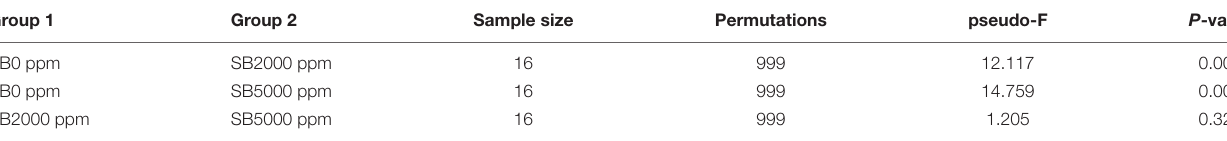
TABLE 3 | PERMANOVA of microbial function based on Bray–Curtis distance of Wolbachia -excluded data. Group 1 Group 2 Sample